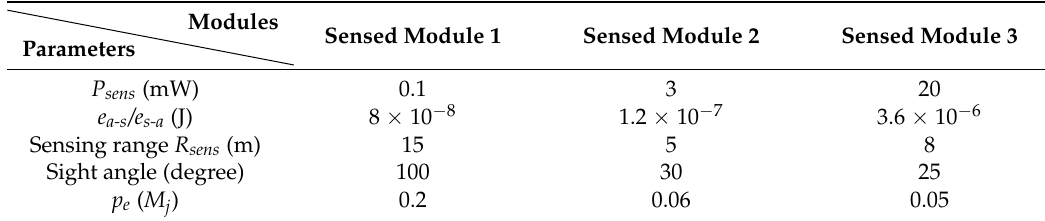
Table 3. The parameters of the different sensed